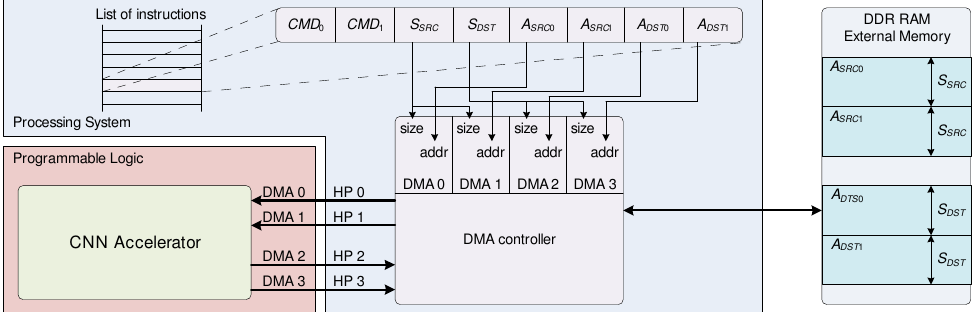
Figure 6. Execution of the instruction on the PS and data exchange between the external memory and CNN accelerator on the